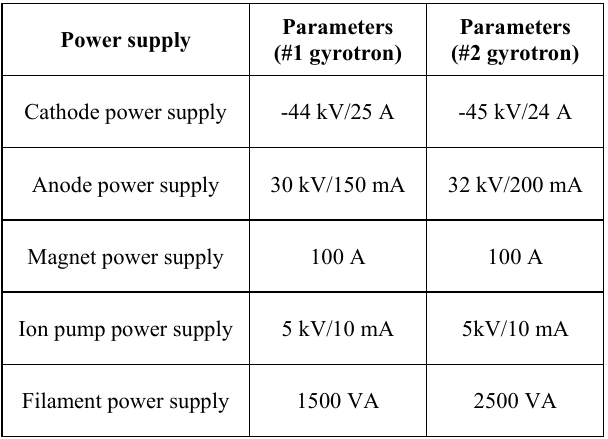
Table 3. Electrical parameters of power supplies for the gyrotron.